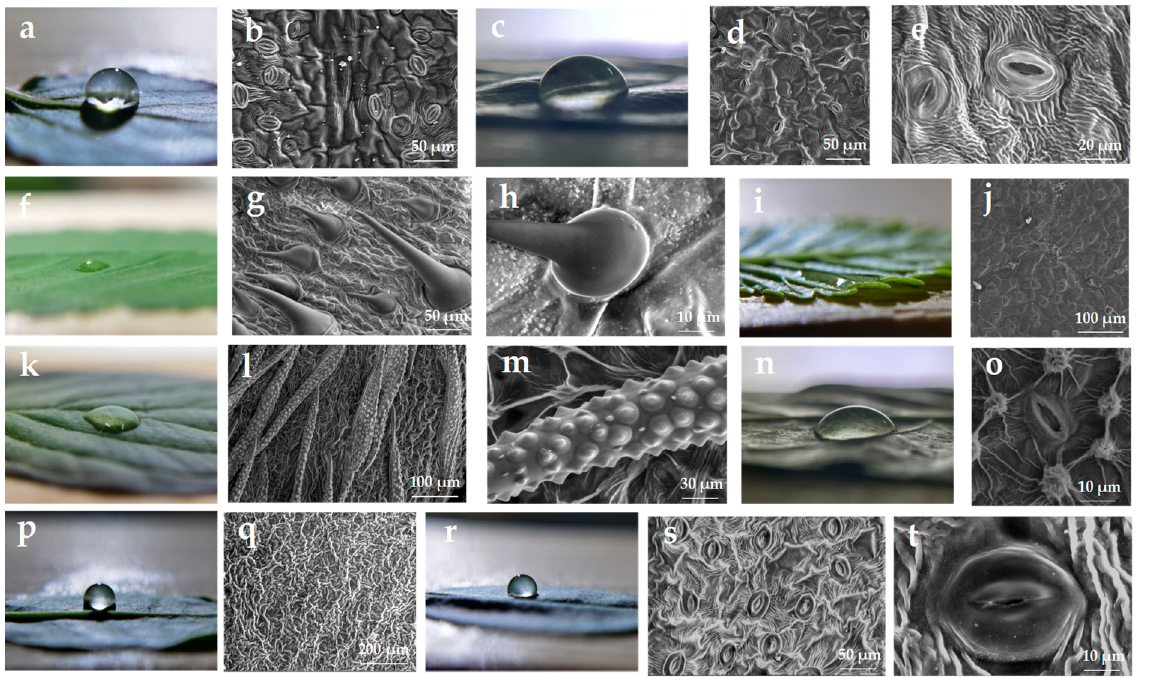
Figure 3. DCAs and microstructures of different species derived using SEM: ( a ): DCA of the Syringa adaxial surface; ( b ): adaxial leaf surface of Syringa (×1600); ( c ): DCA of the Syringa abaxial surface; ( d ): abaxial leaf surface of Syringa (×1000); ( e ): one stomata of the abaxial leaf surface of Syringa (×5000); ( f ): DCA of the Hemiptelea adaxial surface; ( g ): adaxial leaf surface of Hemiptelea (×1600); ( h ): the base of one of a dense mat of glochid trichomes of Hemiptelea (×8000); ( i ): DCA of the Hemiptelea abaxial surface; ( j ): abaxial leaf surface of Hemiptelea (×700); ( k ): DCA of the Cornus adaxial surface; ( l ): adaxial leaf surface of Cornus (×1200); ( m ): one glochid trichome of the adaxial leaf surface of Cornus (×4000); ( n ): DCA of the Cornus adaxial surface; ( o ): abaxial leaf surface of Cornus (×5000); ( p ): DCA of the Buxus adaxial surface; ( q ): adaxial leaf surface of Buxus (×500); ( r ): DCA of the Buxus abaxial surface; ( s ): abaxial leaf surface of Buxus (×2000); ( t ): one stomata of the abaxial leaf surface of Buxus (×12,000).